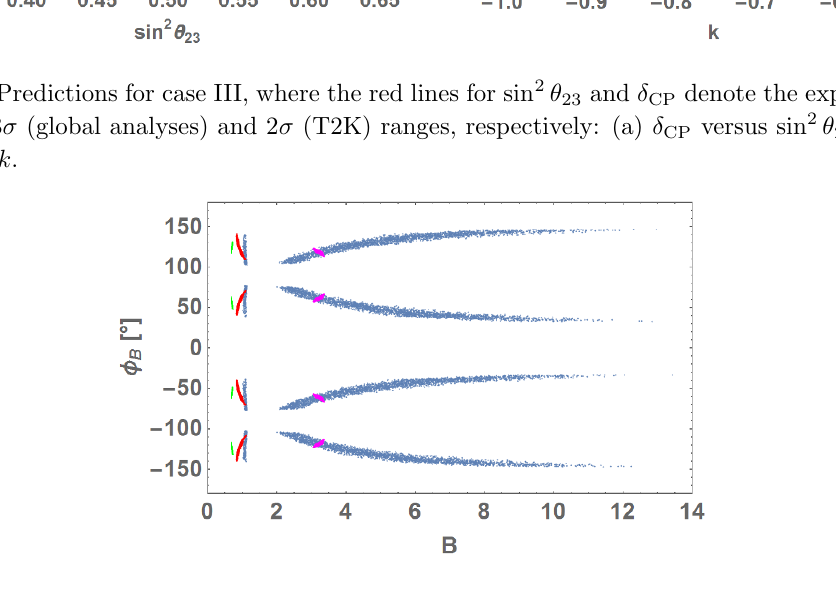
Figure 4 . Allowed regions in B - (cid:30) B plane for TM 1 in NH. The blue, red, green, and magenta dots denote the case I, II, III, and the Littlest seesaw model,